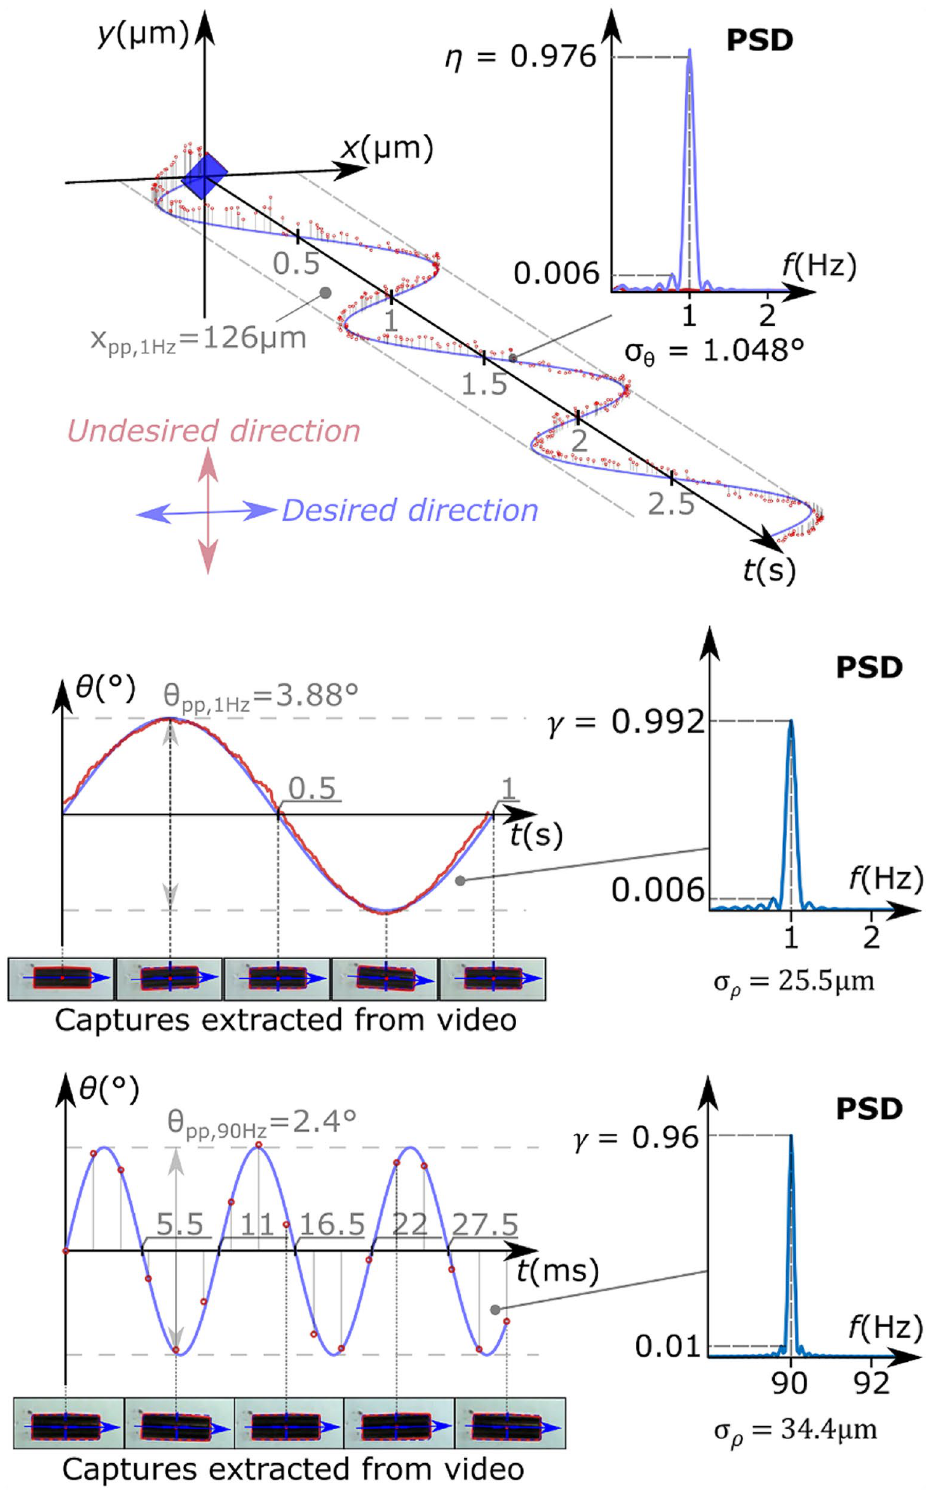
Figure 4. Actuation of a single magnet for three representative configurations (3-DoF control tests). The temporal evolution of three different vibration patterns and their corresponding (normalized with respect to the total power) power spectral densities (PSD, insets) are presented. Above: low-frequency (1 Hz) linear vibration along x of PM4. The initial orientation of the magnet is presented at t = 0. Middle/Below: low/high-frequency torsional vibration along z , of PM2. The blue waveform indicates the desired magnet trajectory. The red circles (or traces) indicate the actual trajectory, as extracted from the video analysis. σ θ / σ ρ indicate the standard deviation of the torsional/linear displacement and η / γ the corresponding